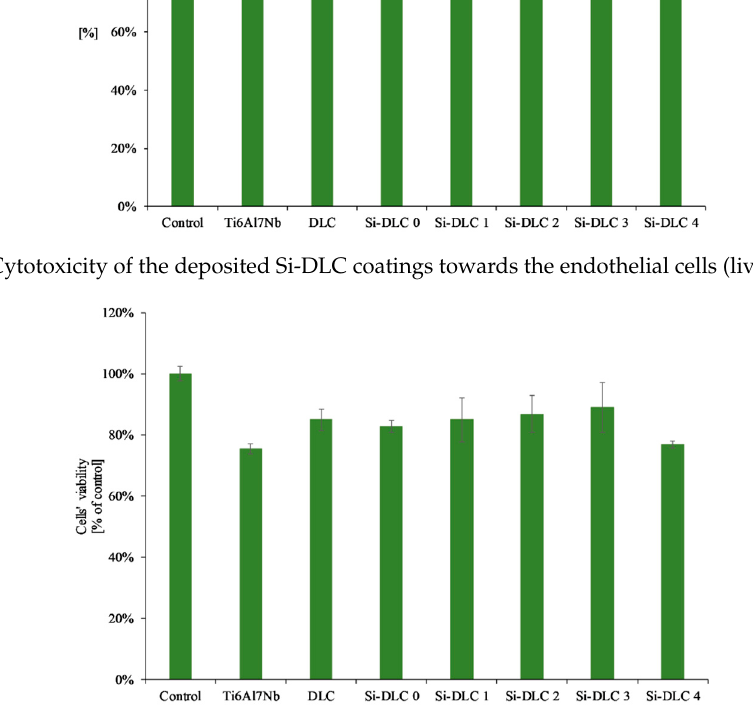
Figure 8. Cytotoxicity of the deposited Si-DLC coatings towards the endothelial cells (live/dead assay).